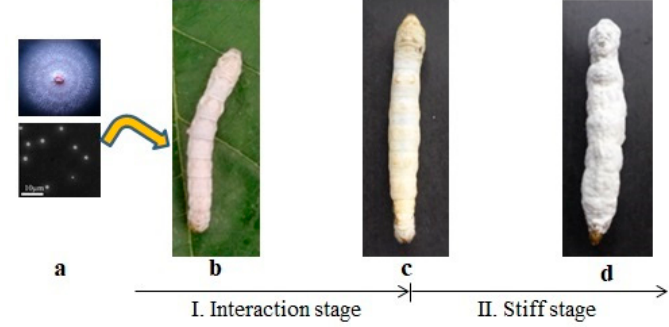
Figure 1. Formation process of B. batryticatus . ( a ) Beauveria bassiana spores; ( b ) silkworm larva; ( c ) death of silkworm infected by Beauveria bassiana ; ( d ) B. batryticatus .